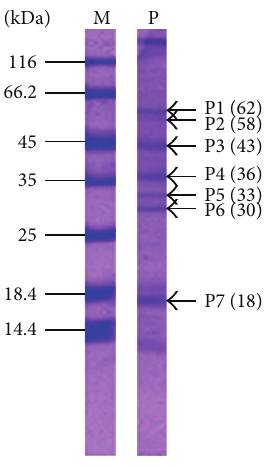
Figure 2: Salivary gland proteins of female An. dirus mosquitoes were separated on 12% SDS polyacrylamide gels and stained with CBB-stained. Labels on the right indicate major protein bands (P1 − P7) and their estimated molecular weights (in blankets). Lane M: protein standard markers (kDa); lane P: salivary glands